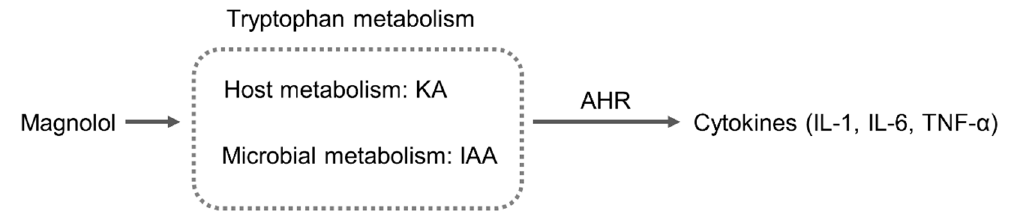
Figure 6. The schematic in the anti-inflammatory effect of magnolol on DSS-induced colitis.